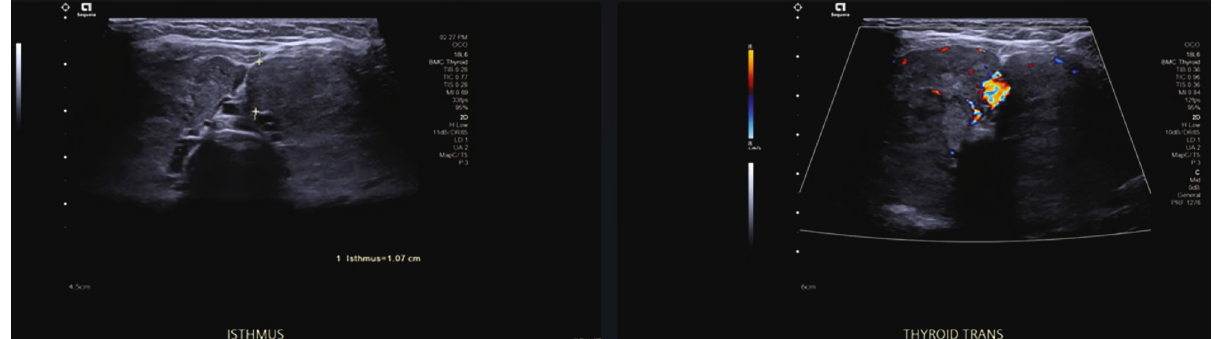
Figure 1: Ultrasound scan of the thyroid shows a markedly enlarged di ff usely heterogenous thyroid gland without well-de fi ned